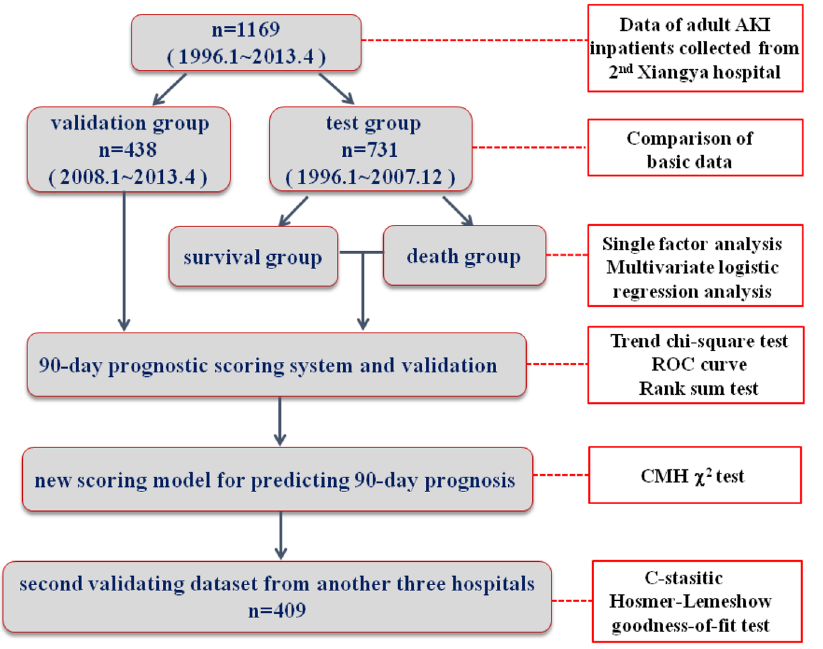
Figure 1. Flow chart of study population selection and research